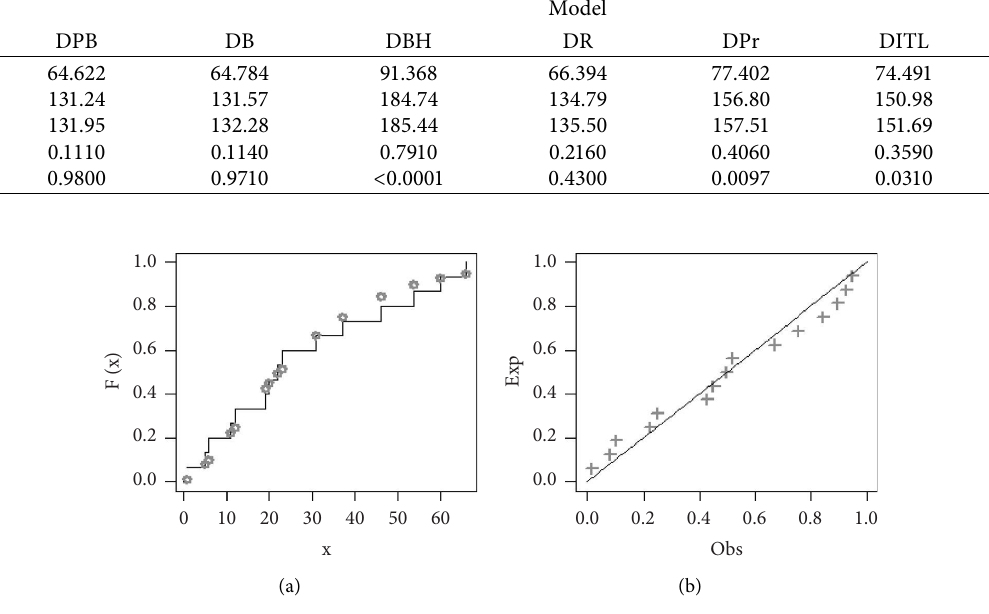
Figure 6: Te empirical CDF (a) and PP (b) plots for data set II.